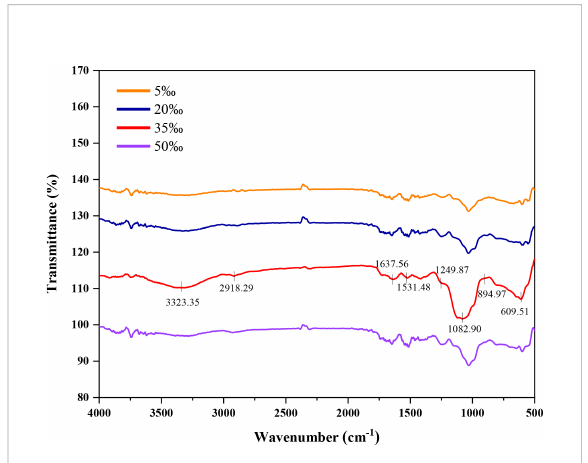
FIGURE 3 Fourier-transform infrared absorption spectra of Porphyridium purpureum FACHB 806 exopolysaccharide under different salinities.